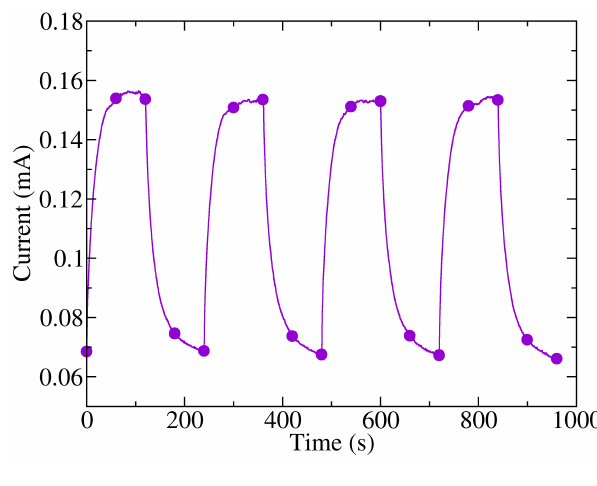
Figure 7. Photodetector “10:20” response to light/darkness